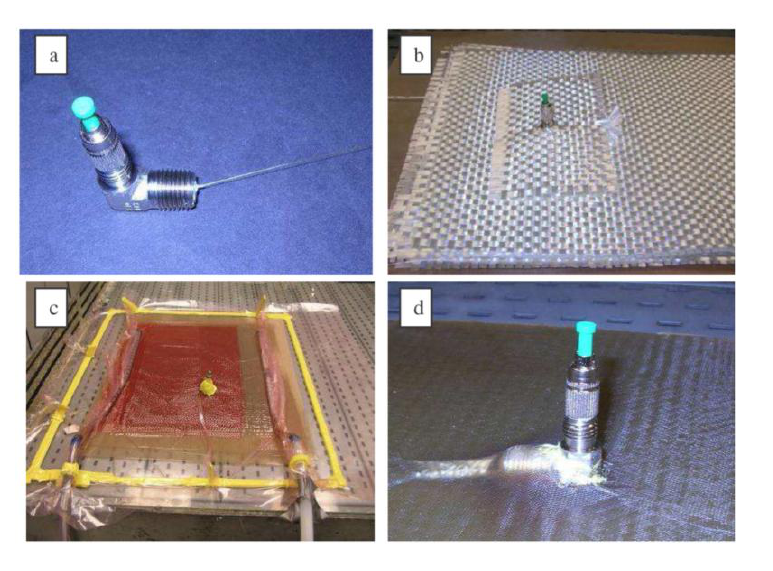
Figure 9. Main steps towards the integration of surface-mounted connector, from